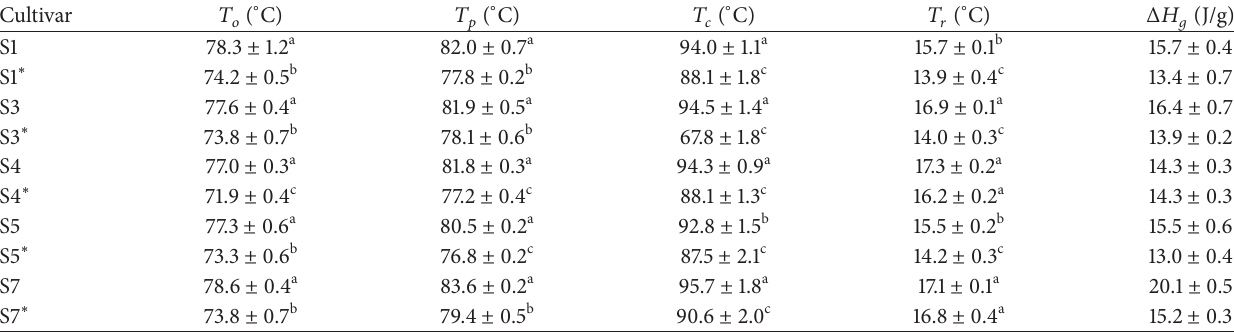
Table 2: Gelatinization parameters x of native and hydroxypropylated ∗ sweet potato starch. Cultivar